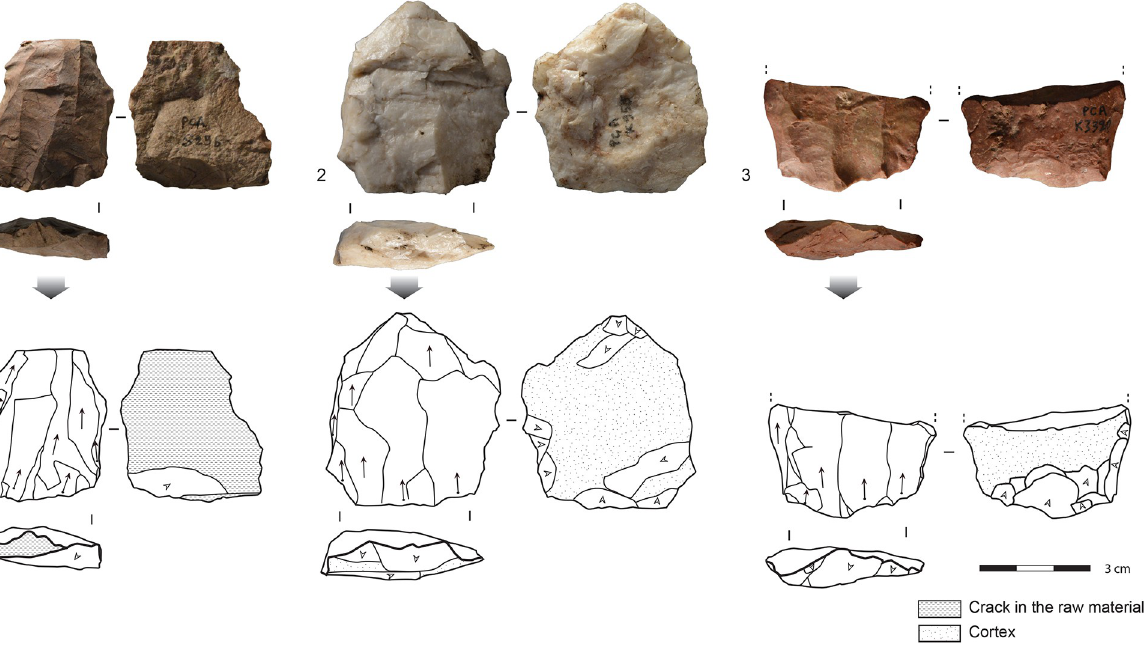
whereas in the upper layers (PBC-PAY) unidirectional cores are mostly flake cores. Blade cores include a broad range of core volumetric exploitations, including a small proportions of cores (n = 26/203 cores, 13%) that have initially been described at Klasies River as “Howiesons Poort cores” [36]. They are characterized by a large debitage surface and pronounced lateral convexities. The most typical examples of "HP cores" are found in layer PCA (Fig 4). Unidirec- tional blade cores produce a broad range of blanks, from narrow blades or bladelets to elon- gated flakes, most often with dorsal blade scars. Bidirectional exploitations is less frequent, and mostly devoted to the production of blades rather than bidirectional flakes. Bidirectional exploitation show no chronological pattern within the sequence.